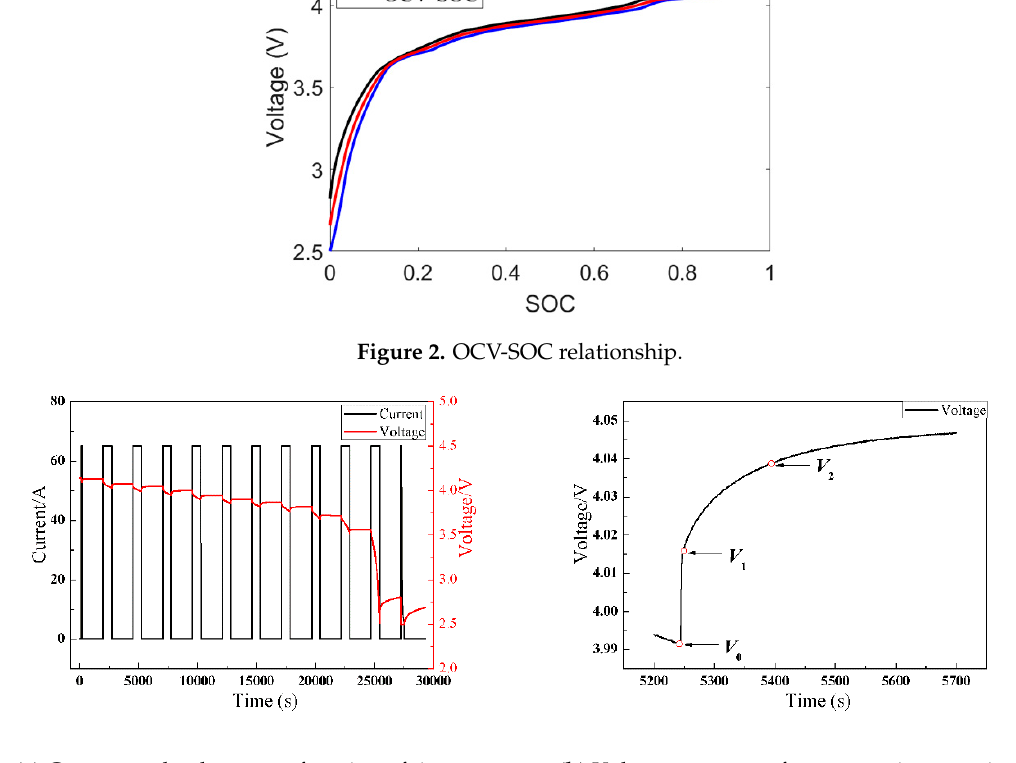
Figure 3. Current step method for model parameterization.